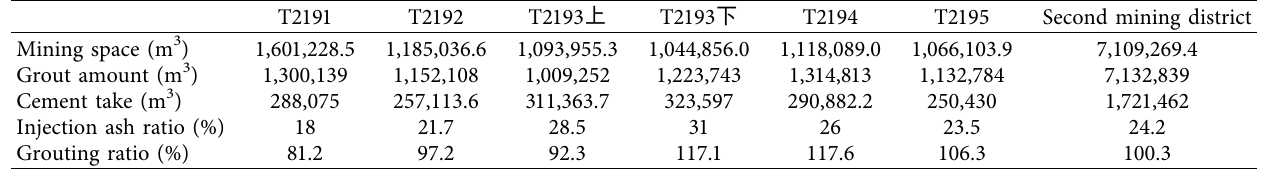
Figure 11: Schematic diagram of grouting system. Table 7: The injection-production ratio table of each side of the second mining district.